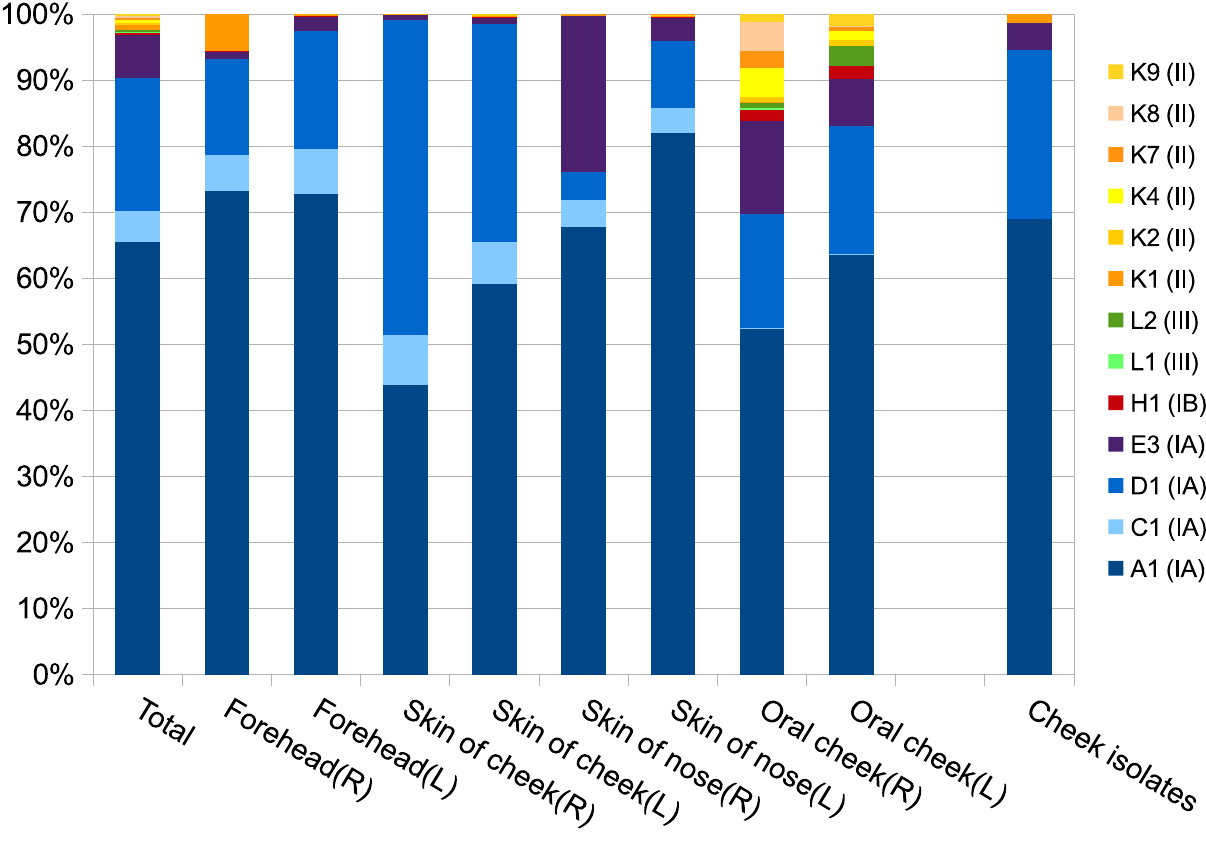
Figure 3. Distribution of P.acnes clones on skin and mucosal sites of a healthy subject revealed by application of the SLST scheme to a pyrosequencing-based analysis of complex microbiotas. Identified SLST types are color-coded. Major types IA 1 , IB, II and III are depicted in blue, red, yellow, and green and nuances thereof, respectively. The rightmost column indicates the SLST type distribution of 74 P. acnes isolates from a parallel sample of the skin of the cheek of the same subject. SLSTs represented by less than 0.03% of reads and reads that remained unassigned are not shown. See table S2 for distribution of all reads.